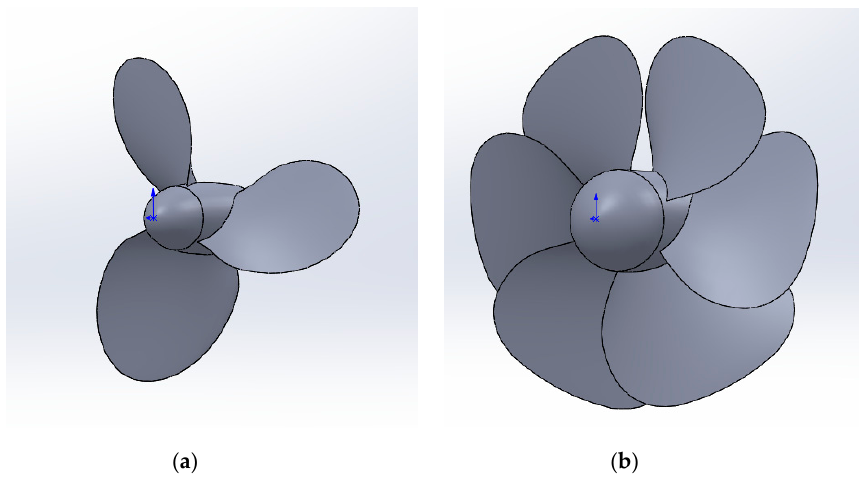
Figure 1. Geometric model of propellers: ( a ) Propeller-76; ( b ) Propeller-131.